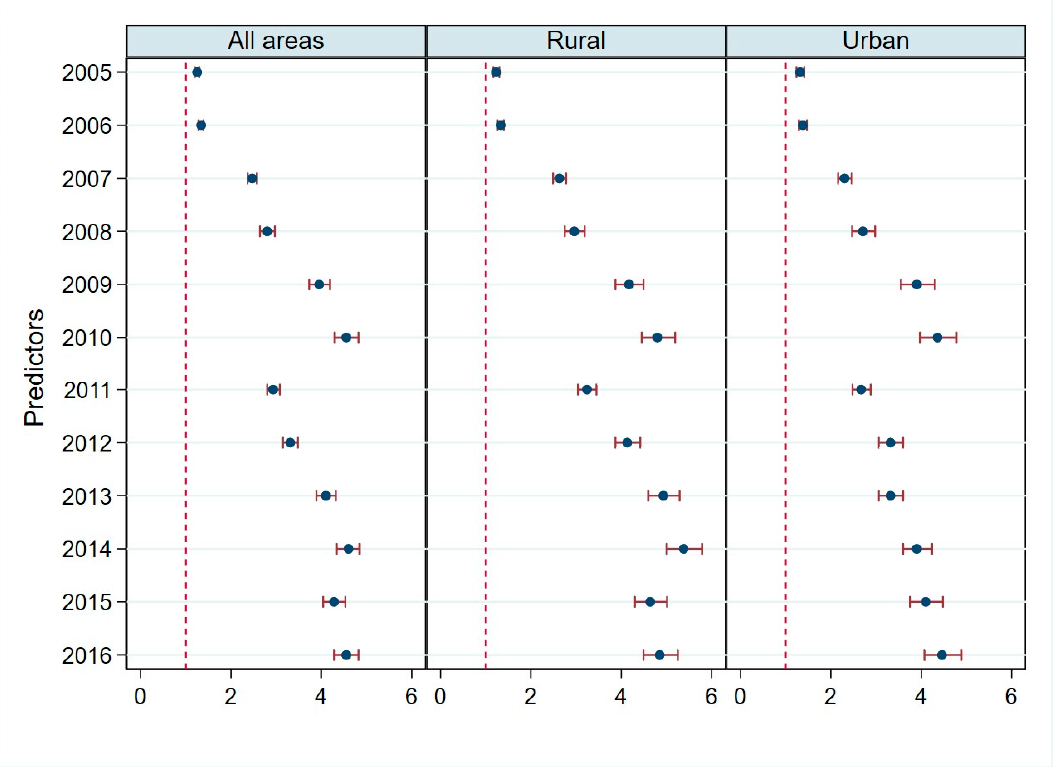
Table 1. Determinants of children’s DTP immunization status. 2004